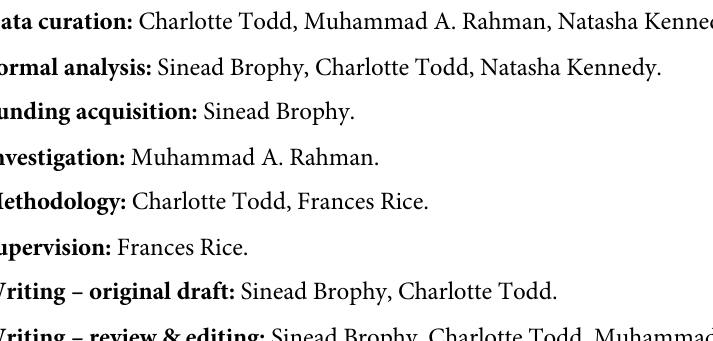
S1 Table. Codes used to define depression in general practice data. S1 Fig. Flow diagram of inclusion and exclusion within the